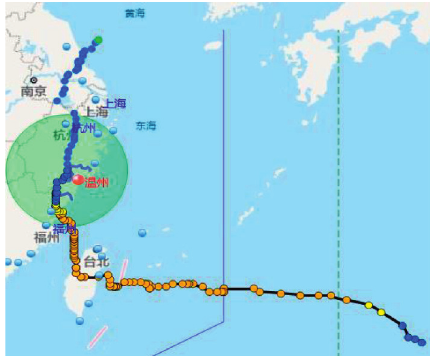
Figure 1: Route of Typhoon Morakot.